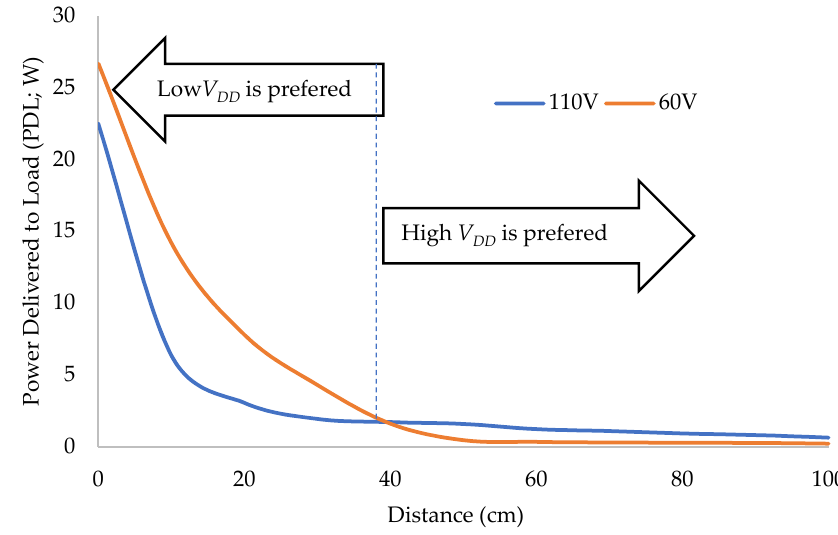
Figure 4. PDL vs. distance and input voltage VDD.